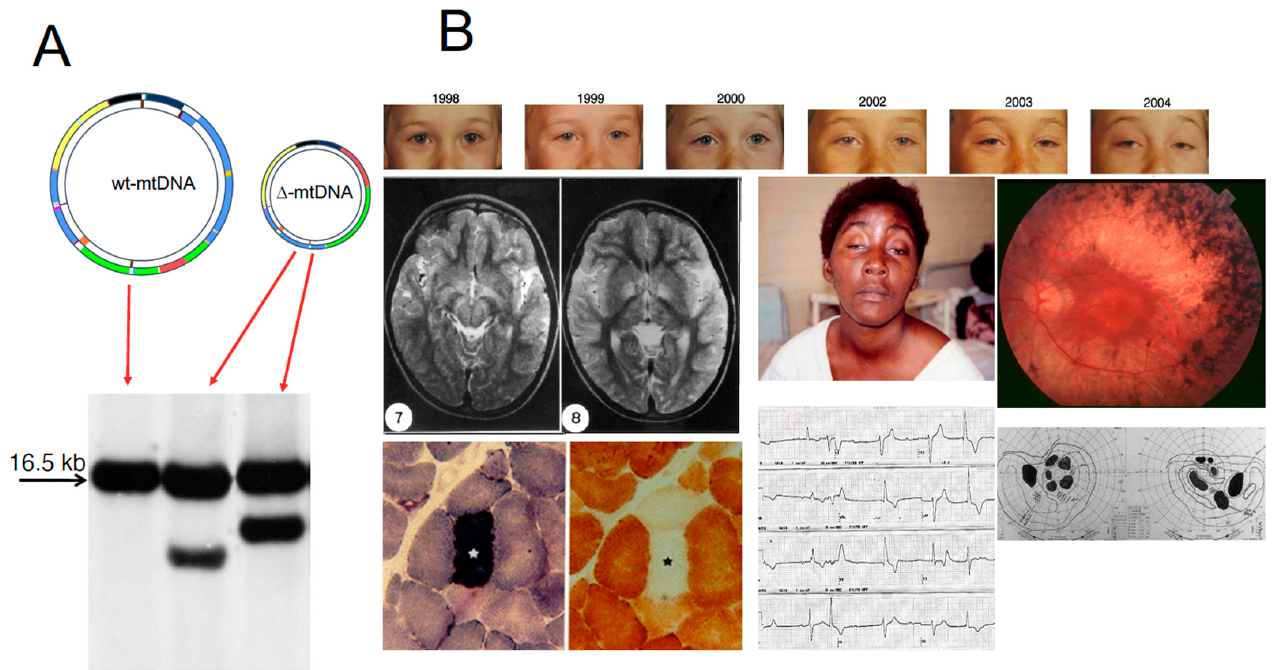
Figure 5. KSS: molecular and clinical synopsis. ( A ). Cartoon displaying the structure of wild-type and deleted mtDNA molecules, linearized, and subjected to Southern-blotting with audioradiography against purified radiolabeled human mtDNA. The upper band present also in the wild-type mtDNA indicates linearized normal mtDNA (wt-mtDNA). The lower bands present in the other two lanes corresponding to muscle DNA from KSS patients are deleted species ( ∆ -mtDNA) co-existing with wt mtDNA (heteroplasmy). ( B ). In the upper set of panels progression of bilateral ptosis in a KSS adolescent. Two FLAIR-T2 transverse brain sequences display multiple lesions. A transverse section of a muscle biopsy shows a ragged-blue fibre (SDH-hyperintense) associated with several COX-negative fibres. The lady depicted in the figure displays bilateral eyelid ptosis (with ophthalmoparesis) and facial weakness. Her ECG shows numerous extrasystolic aberrant impulses. On the left, the fundus oculi shows retinal dystrophy, with irregular defects of both visual fields (bottom).